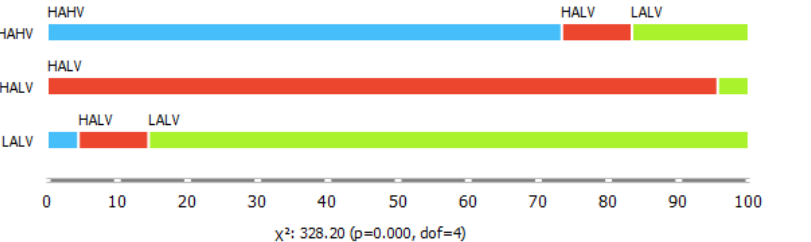
Figure 5. Confusion matrix of the HAHV (Happiness), HALV (Anger), LALV (Sadness) recognition rate.